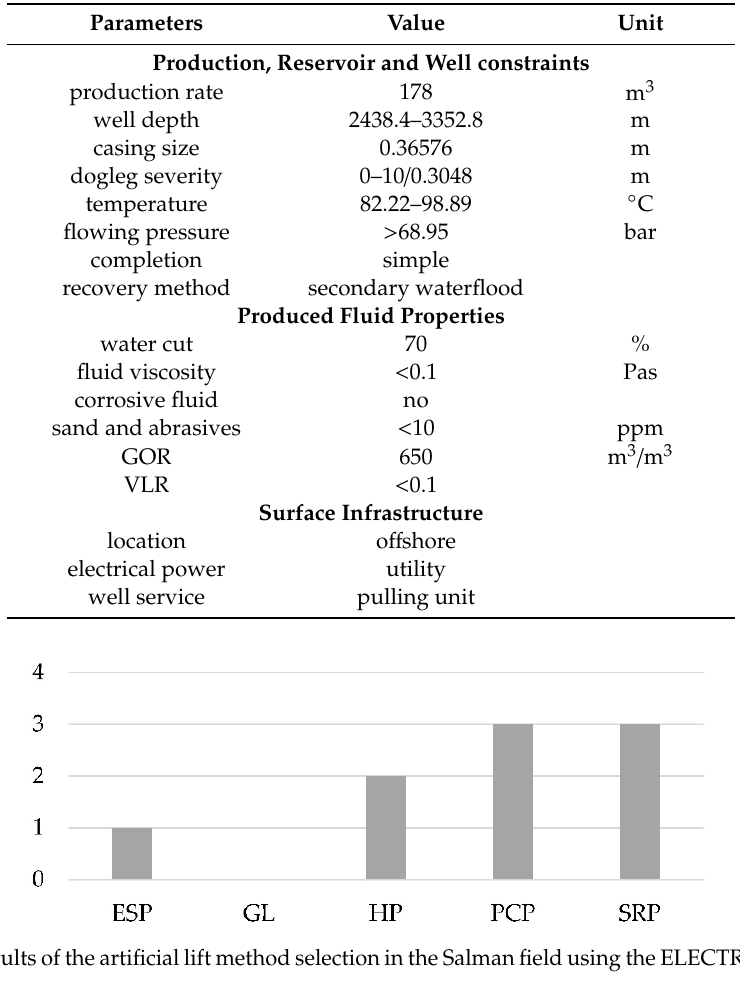
Figure 5. Results of the artificial lift method selection in the Salman field using the ELECTRE model